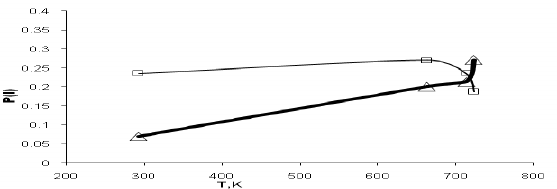
Fig.5. Structural damage of the alloy as a function of annealing temperature: ( □ ) the curve is constructed according to the data on the change in the average spectral density of the reflection brightness in the interval surrounding the spectrum maximum and ( ∆ ) the same, but in the spectrum interval with the increased absorption